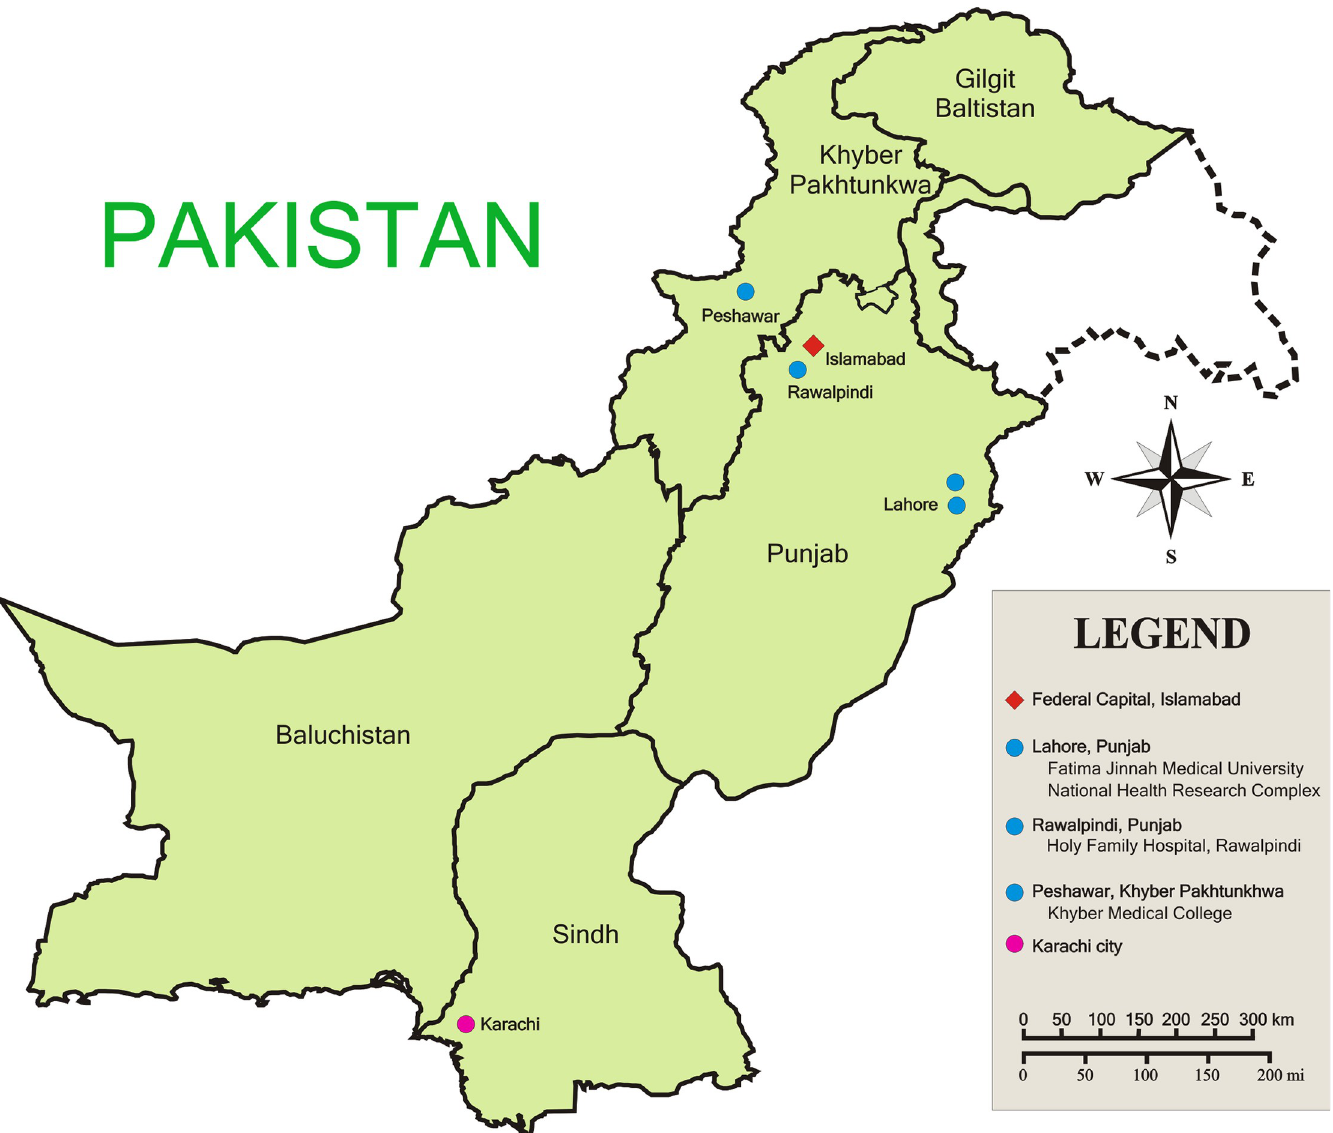
Fig 1. Map of Pakistan showing study sites in provinces of Punjab and Khyber Pakhtunkhwa. The location of Karachi city is also shown where the first dengue outbreak was reported in Pakistan. The map was prepared in CorelDraw software. Pakistan Base Map URL: https://commons.wikimedia.org/wiki/File:Pakistan_Base_